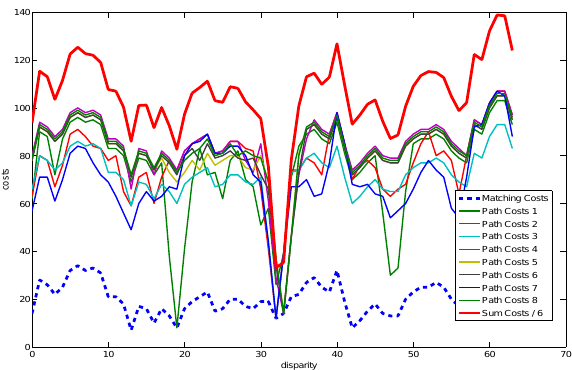
sity I less than I ( p )